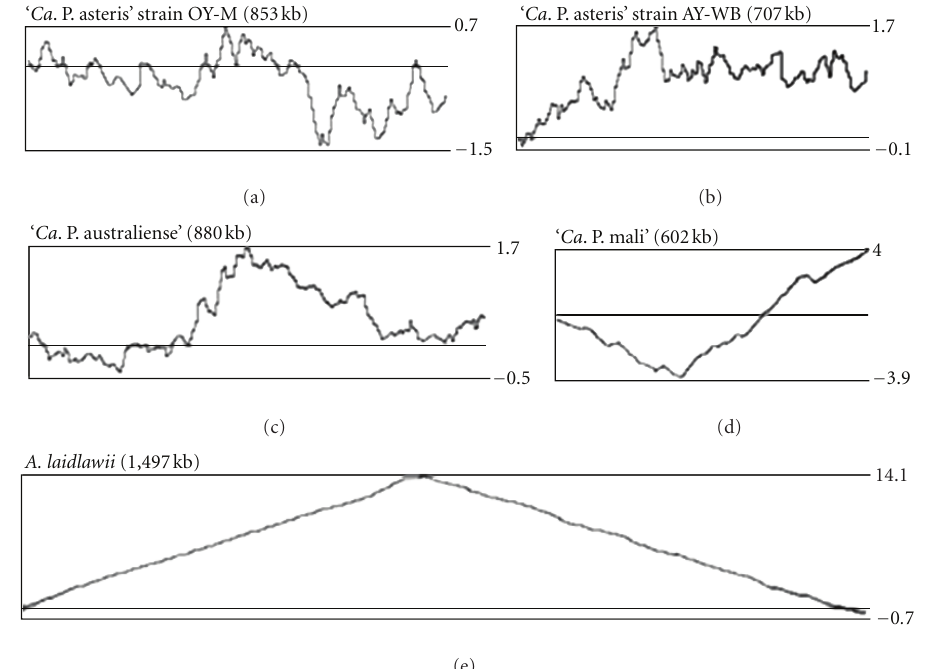
Figure 2: Cumulative GC skew analysis [(C − G)/(G + C)] of the chromosomes of the two ‘ Ca . P. asteris’ strains OY-M and AY-WB, ‘ Ca . P. australiense’, ‘ Ca . P. mali,’ and A. laidlawii . A window size of 5000 bases was used for calculation. Maxima and minima values obtained are indicated.